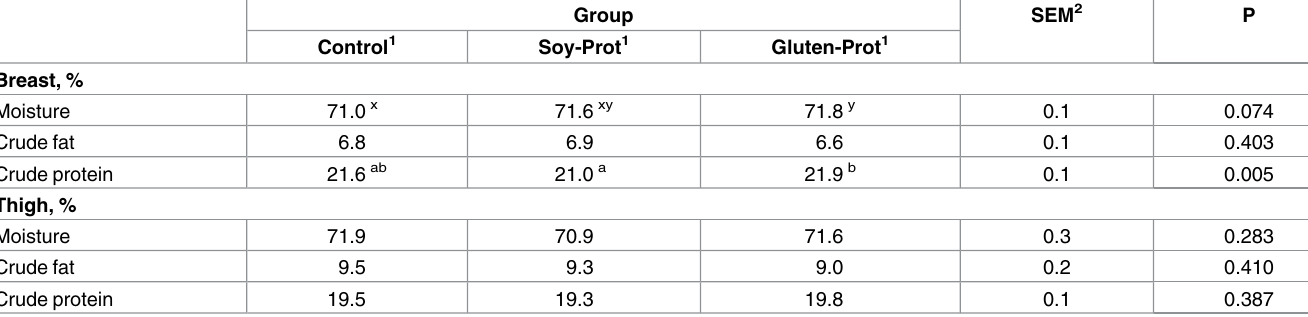
Table 6. Influence of diets on broiler chickens breast and thigh meat chemical composition.